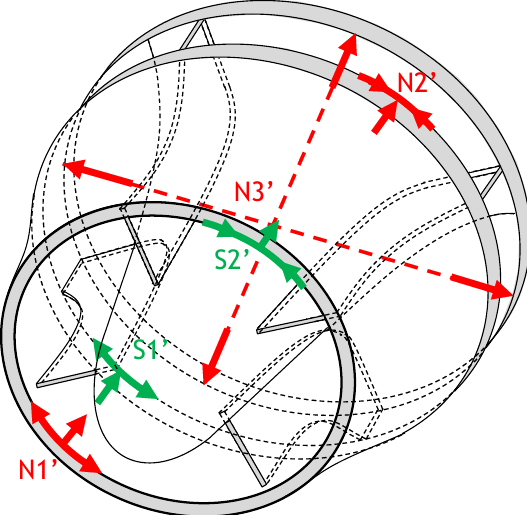
Figure 5. SCP for a shrouded centrifugal pump impeller with